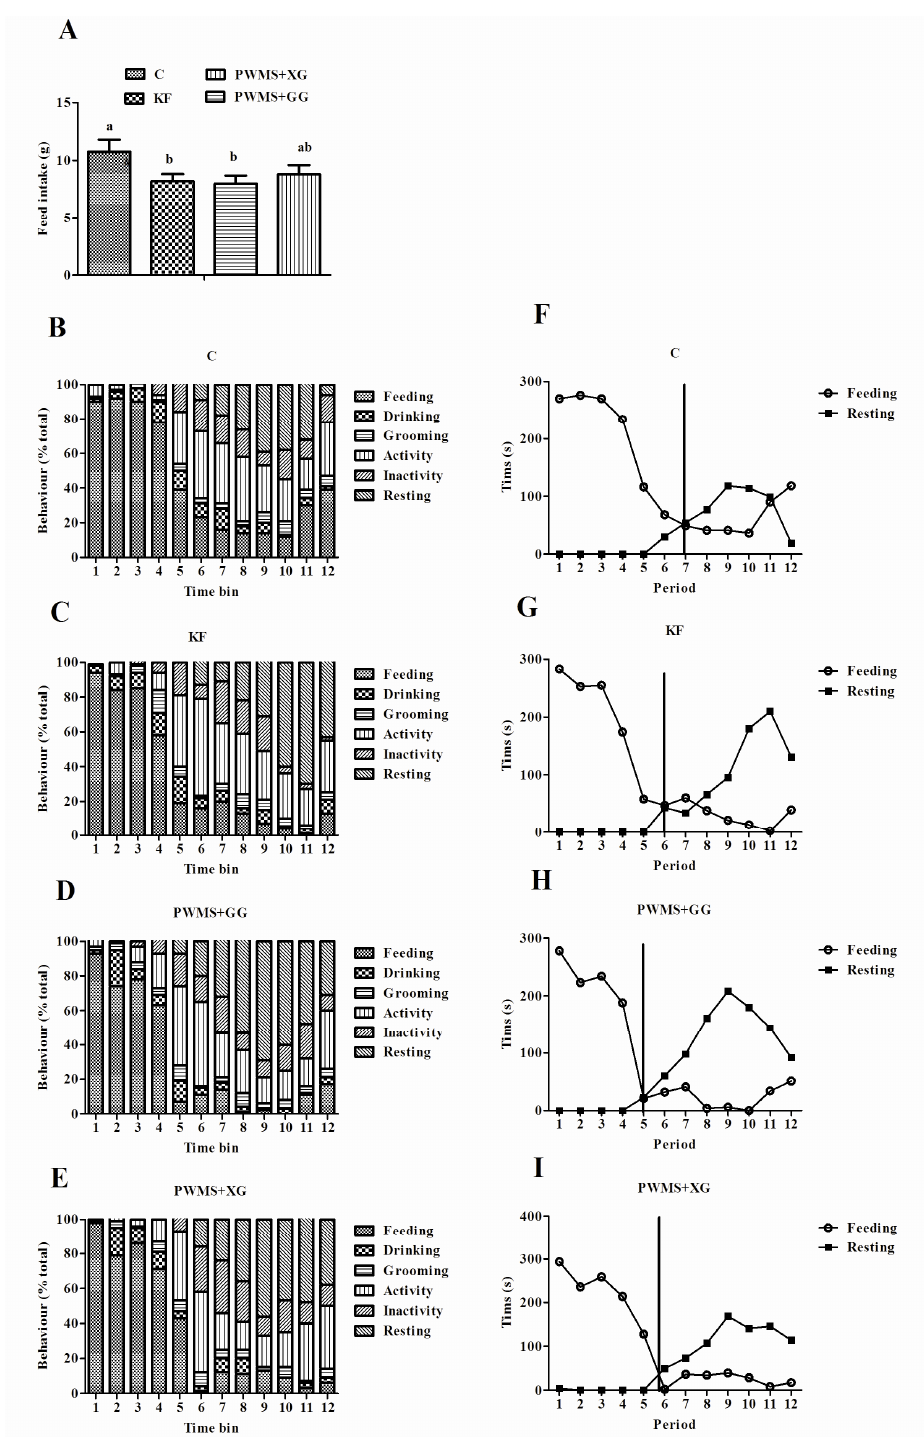
Figure 2. Food intake ( A ) in rats was calculated at 1 h and is presented as mean ± SEM for n = 8 per group. Bars with different letters indicate a significant difference ( p < 0.05). Periods 1–12 correspond to the twelve 5 ‐ min time bins comprising the 60 min test session; ( B – E ) Frequency data within each behavioral category are expressed as a proportion of the total number of observations per time bin; ( F – I ) correspond to crossover graphs illustrating the point of transition from eating to resting. The perpendicular line indicates satiety point. Diets were control (C) or supplemented with 2% fiber of konjac flour (KF), pregelatinized waxy maize starch plus guar gum (PG), or pregelatinized waxy maize starch plus xanthan gum (PX).